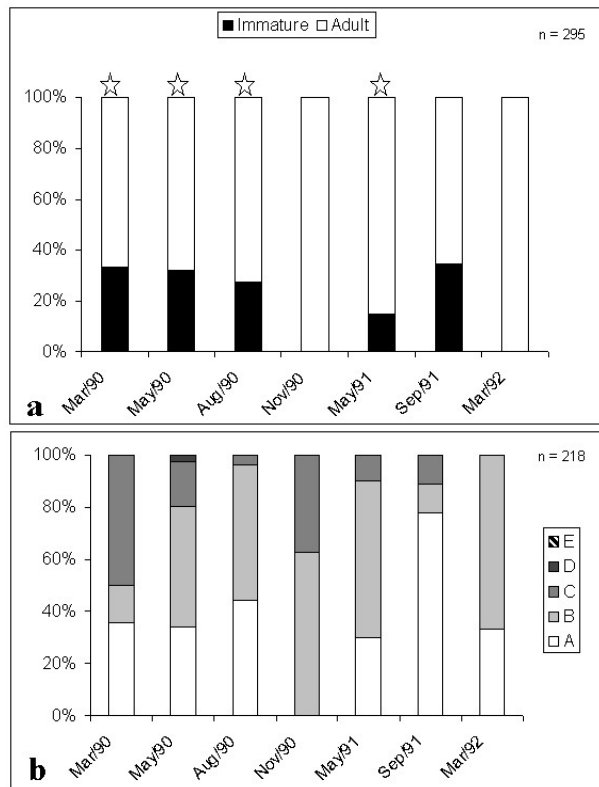
Fig. 6 . Proportion of males (a) and females (b) of the Bay whiff in each macroscopic maturity stage considered in this study. Stars means significantly different - tested by Chi- square ( χ 2